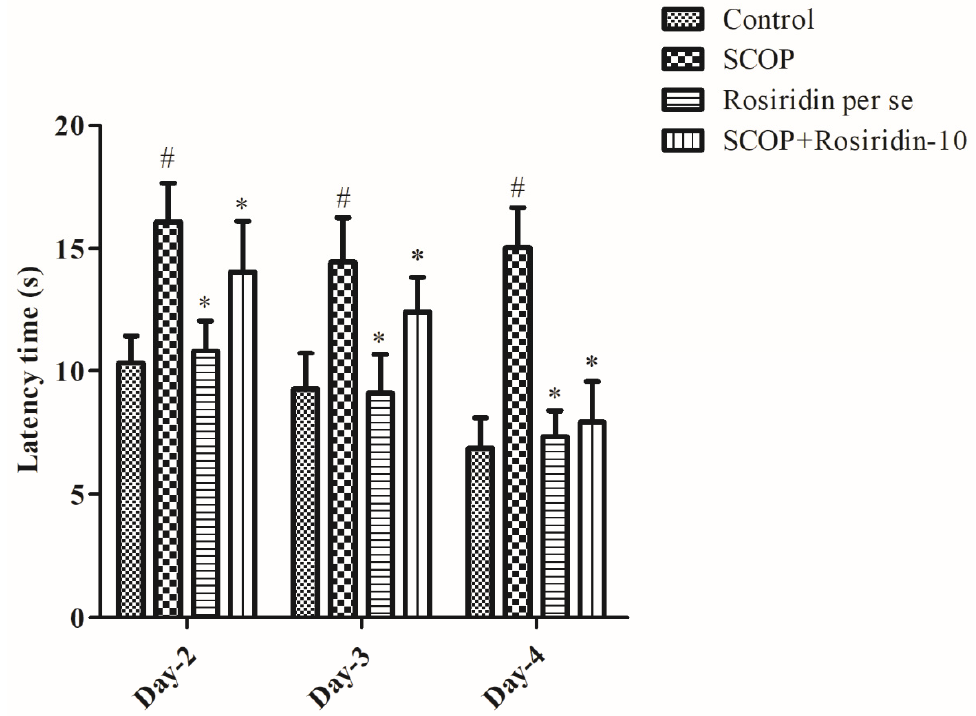
Figure 2. Depicts the effect of the rosiridin during the Morris water maze acquisition process. Mean ± S.E.M. ( n = 6). # p < 0.001 vs. normal control, * p < 0.05 vs. scopolamine control. Two-way ANOVA followed by Bonferroni post analytic